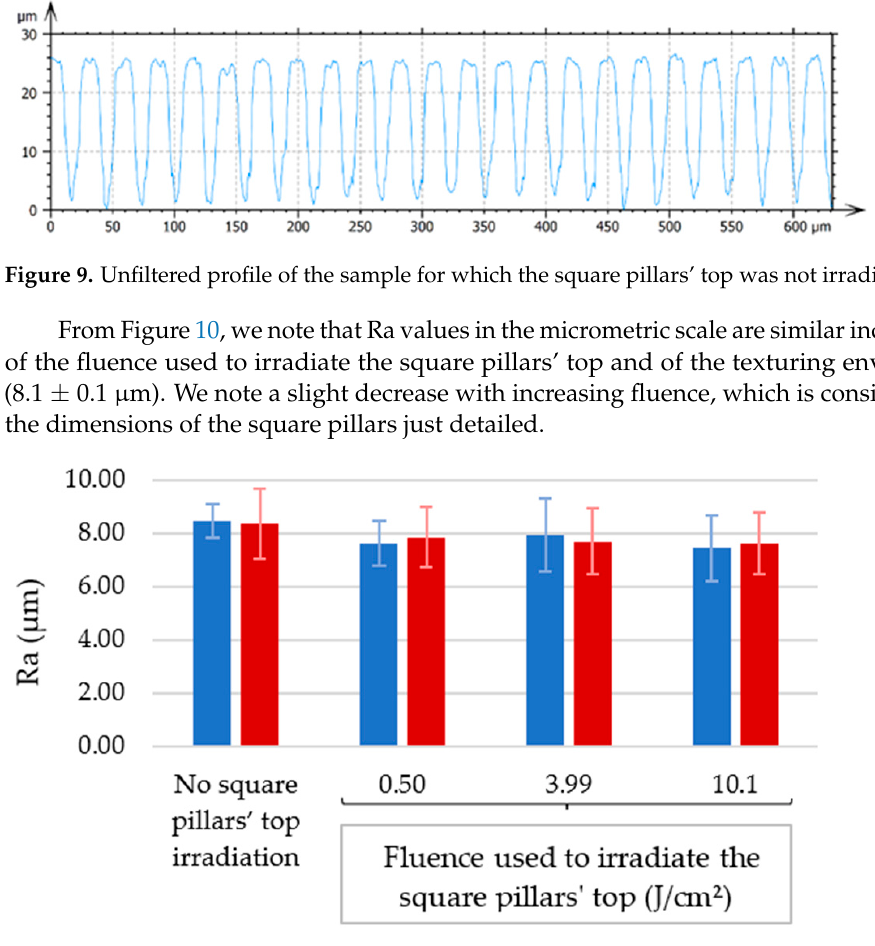
Figure 10. Arithmetic mean roughness (Ra) of the samples for which the square pillars’ top was irradiated using different fluences in ambient air or under a CO 2 flow.